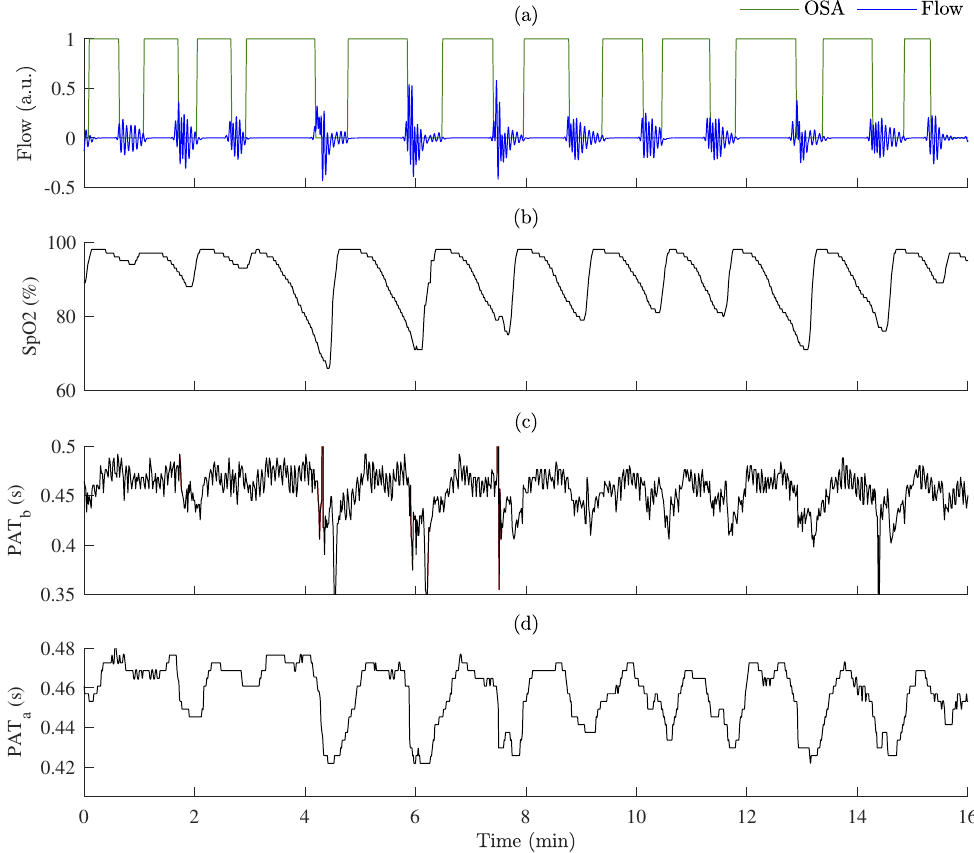
Figure 6. An example of PAT variations during OSA episodes: ( a ) respiration flow signal with labeled OSA episodes; ( b ) SpO2 variations; ( c ) PAT before post-processing, PAT b ; ( d ) PAT after post-processing, PAT a